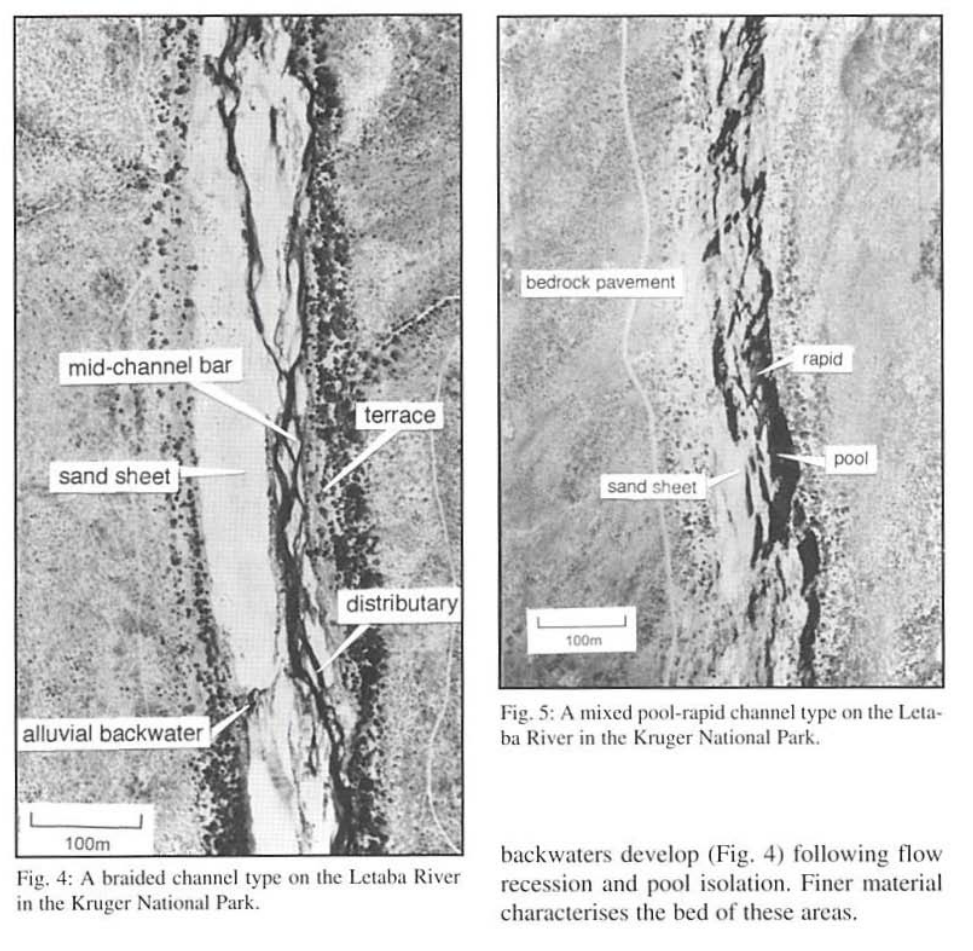
Fig. 4: }\ bmidcd ch;lIIlleltypc on the Letaha River in the Kn'gcr National P;lrk.